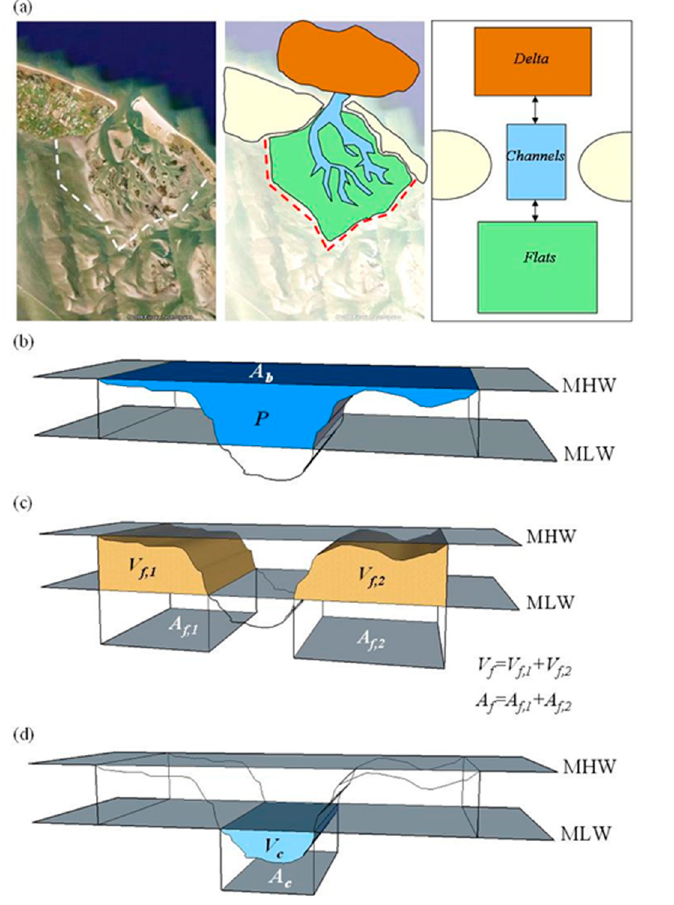
Figure 3. The three-elements schematisation ( a ) for a tidal inlet in the aggregated scale morphological interaction between tidal basin and adjacent coast (ASMITA) and the definitions of the hydrodynamic and morphological parameters tidal prism P ( b ), area A f and volume V f of tidal flats ( c ), area A c and volume V c of channels ( d ).